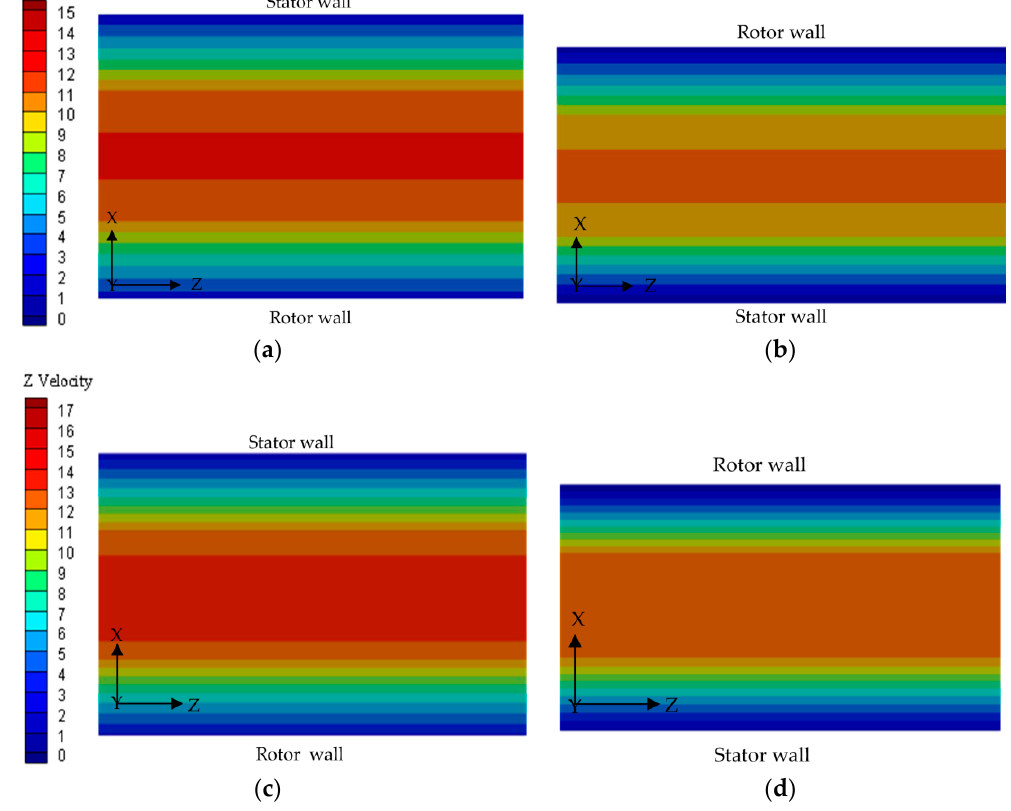
Figure 11. Z-direction velocity profile of the short seal (PD = 1.38 MPa): ( a ) the maximum clearance cross section ( b ) the minimum clearance cross section, [L = 13.13 mm], ( c ) the maximum clearance cross section ( d ) the minimum clearance cross section, [L = 38.1 mm].